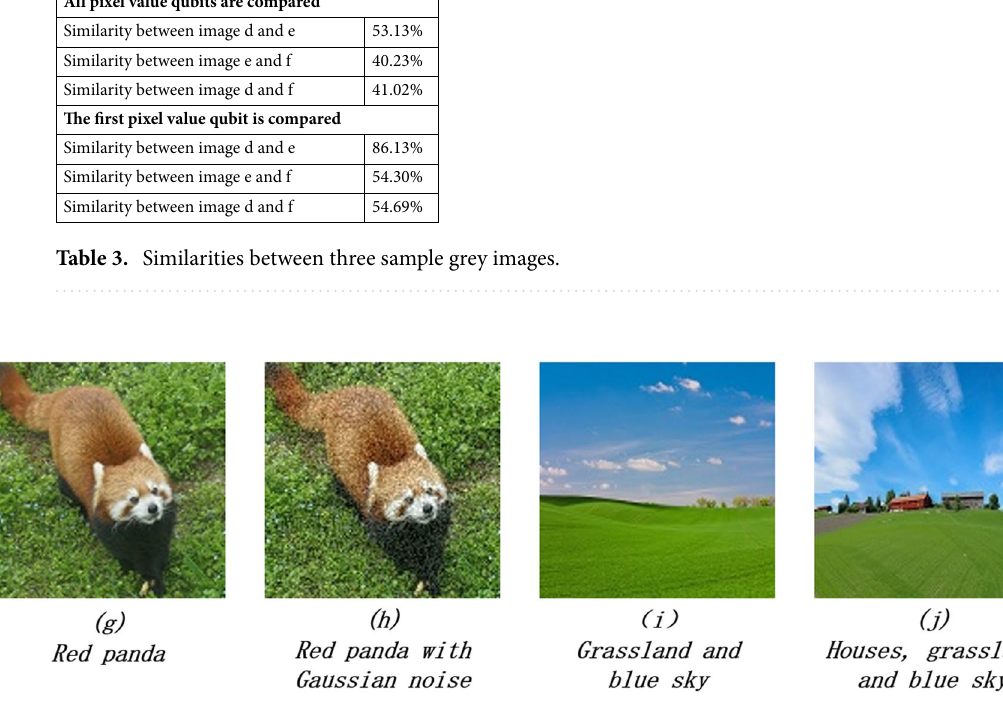
Figure 8. Four color images used for calculating similarities.